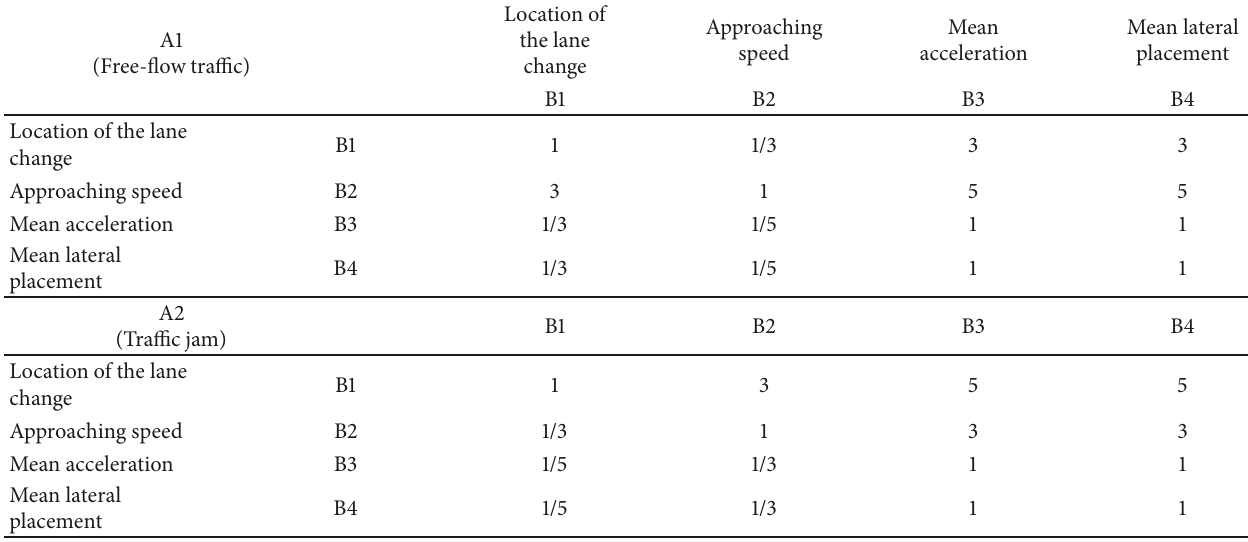
Table 6: Data for the different strategies.